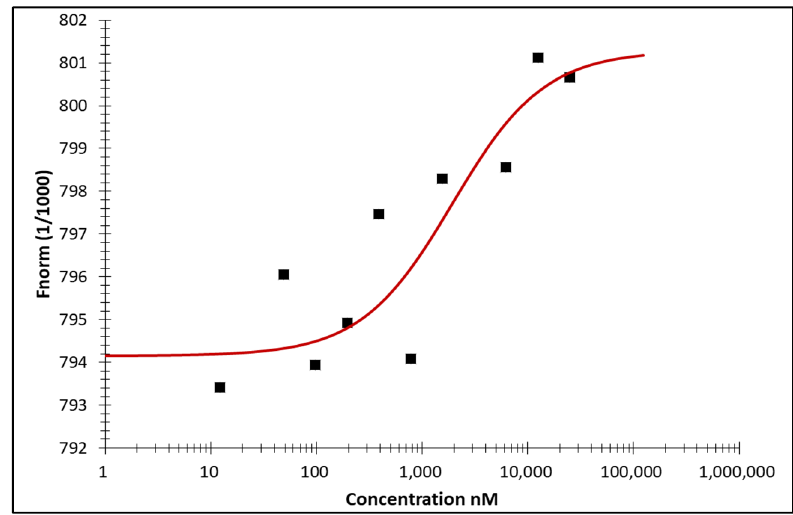
Figure 3. Binding of artemisinin isoniazide dimer to human c-MYC, as detected by microscale thermophoresis. The binding curve shows a concentration-dependent change in the fluorescence signal. Data fitting was achieved according to the law of mass action. K d = 1.19 ± 0.24 µ M, calculated after three independent repetitions.